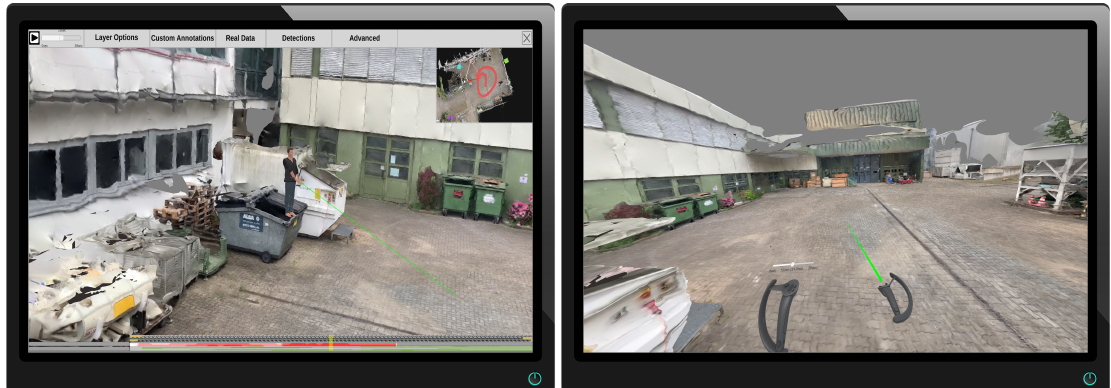
Figure 30. Collaborative setup with multiple monitors connected to the system. One monitor shows the usual view of the 4D reconstruction ( Left ) and the other one, a view from the simultaneous observer’s perspective in VR ( right ). An avatar of the VR observer is displayed in the desktop interface ( Left